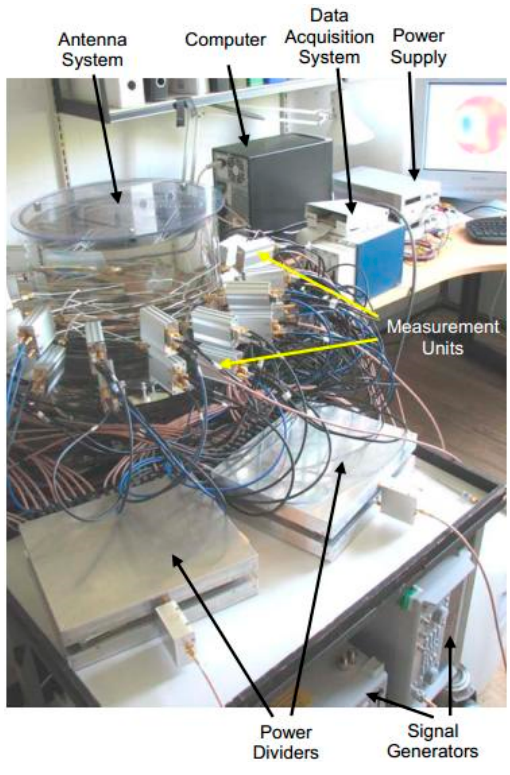
Figure 6. Photograph of the 3D imaging system [59].